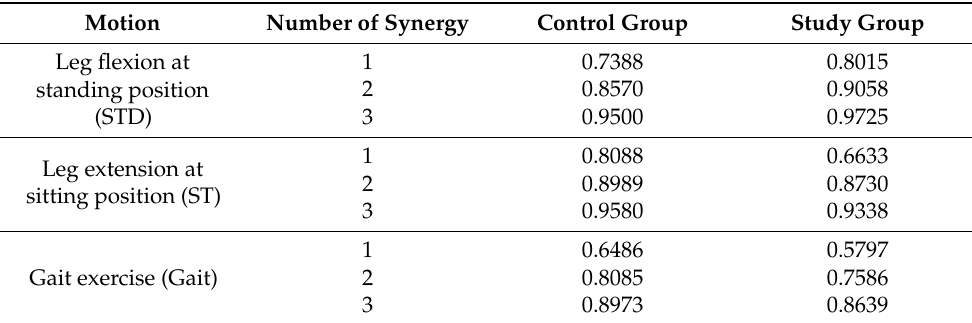
Table 1. The mean variability accounted for (VAF) of Control Group (CG) and Study Group (SG) performing different motions when k equals different